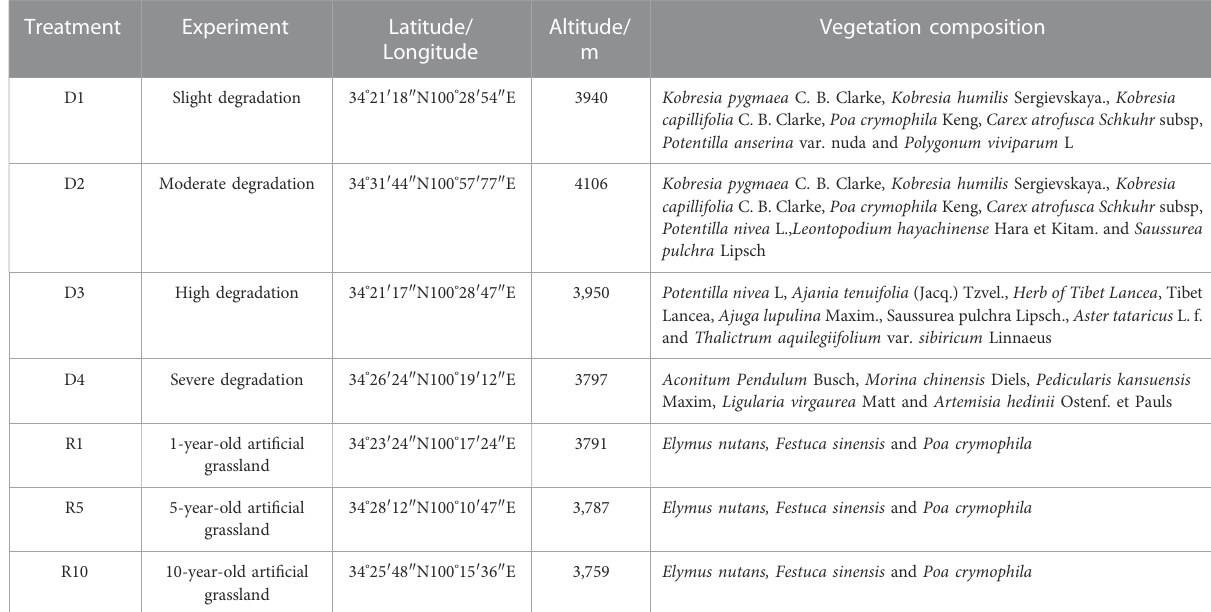
TABLE 2 The basic information of the experimental